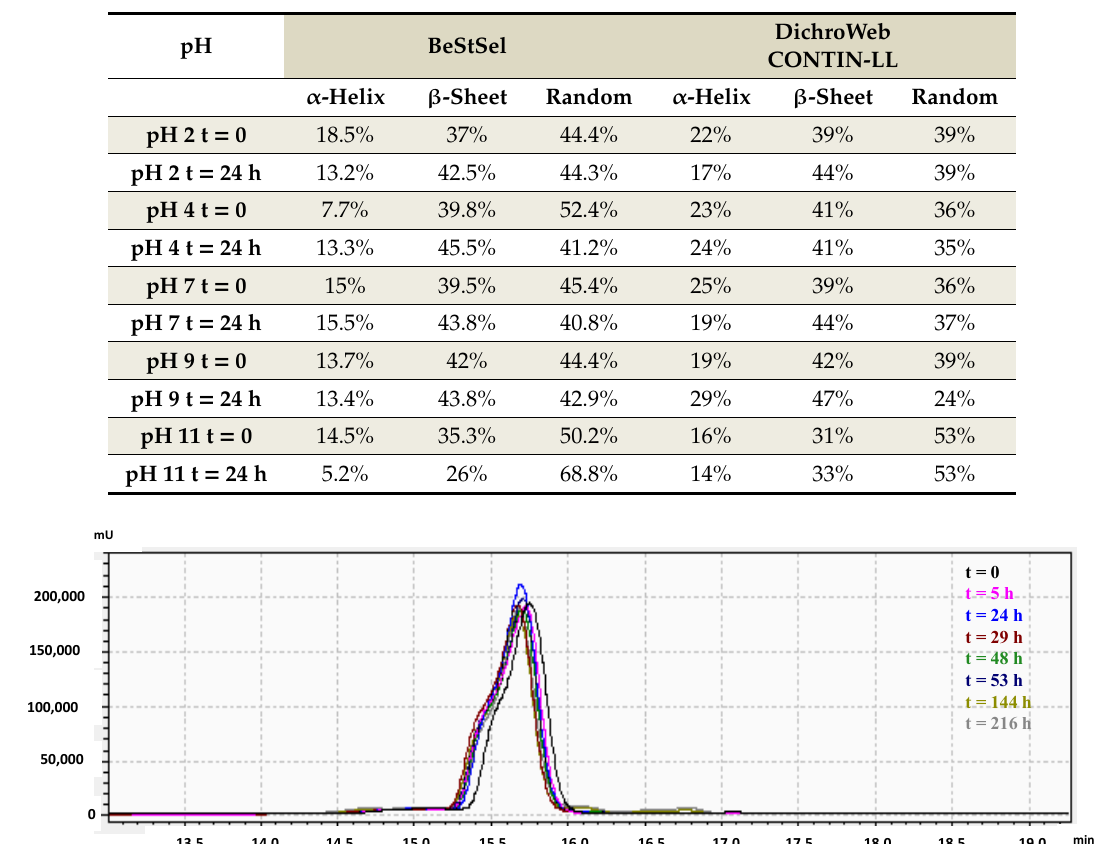
Table 4. Secondary structure contents of RiLK1 at di ff erent pH values determined by BeStSel and DichroWeb server.